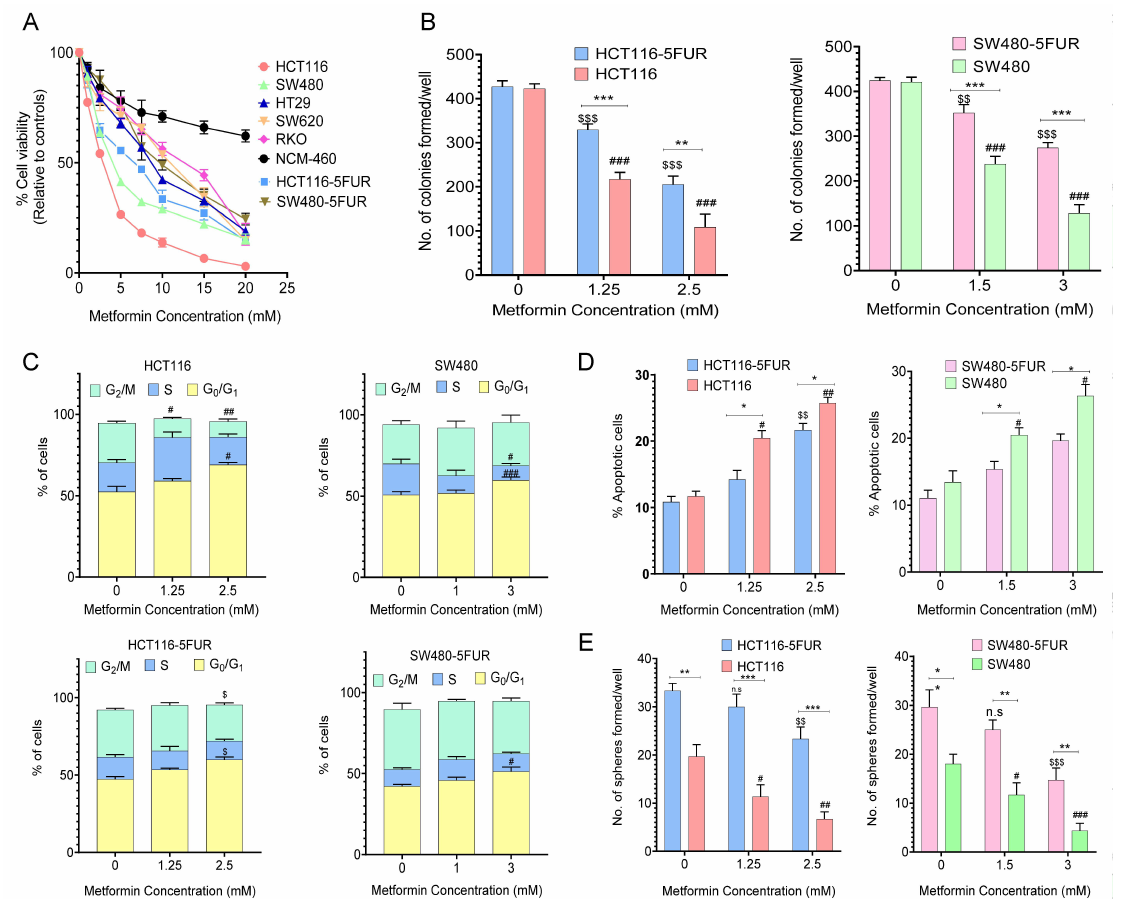
Figure 1. Anti-proliferative effect of metformin in parental and 5FUR CRC cells. ( A ) Measurement of percentage cell viability after treatment with metformin (1–20 mM) for 48 h in a panel of CRC cell lines by CCK-8 assay. ( B ) Colony-forming ability of parental and 5FUR CRC cells after treatment with different concentrations of metformin for 48 h. ( C ) Cell cycle analysis and ( D ) apoptosis measurement in parental and 5FUR CRC cells after treatment with different concentrations of metformin for 48 h. ( E ) Spheroid-formation capacity of parental and 5FUR CRC cells after treatment with metformin for 48 h. Statistical significance was determined by Student’s t -test. (Comparison between Parental vs. 5FU-resistant-* p < 0.05, ** p < 0.01, *** p < 0.001; comparison between Control and treatment groups for HCT116 and SW480- $ p < 0.05, $$ p < 0.01, $$$ p < 0.001; comparison between Control not significant.